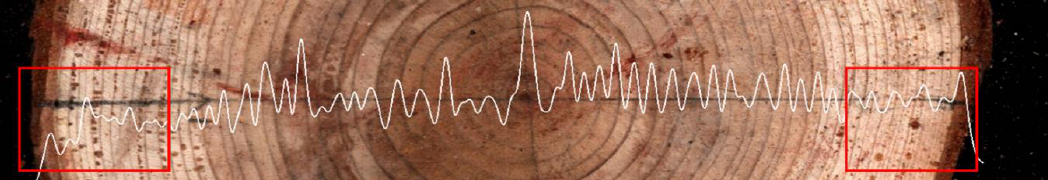
Figure 19. The analysis of filtered waveform and annual ring comparison of the larch #6 disk.